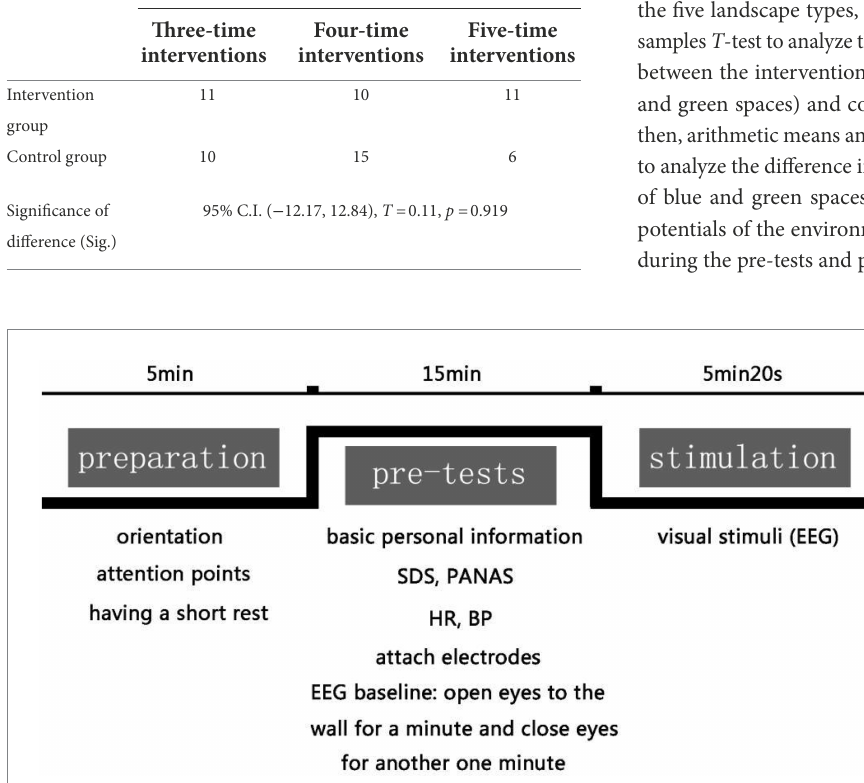
TABLE 2 Distributions of the participants among the different times of interventions in the intervention group and control group. Group Times of intervention (No. of the participants)